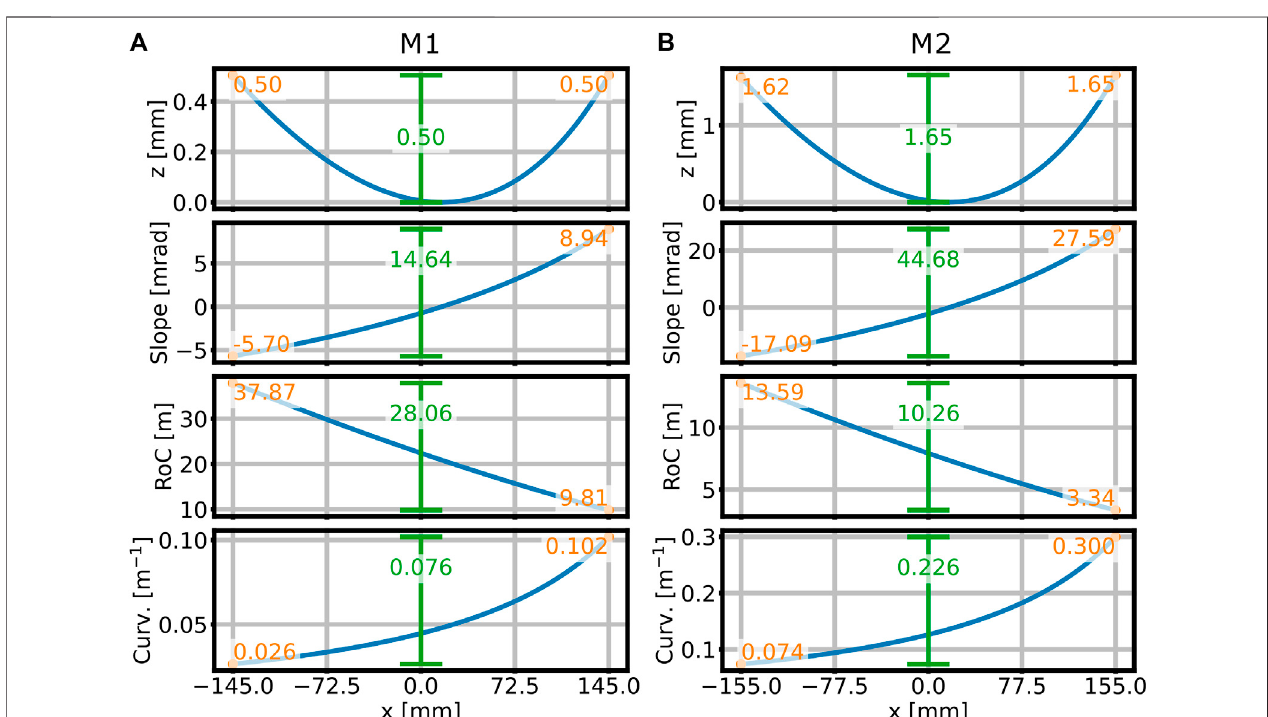
FIGURE 7 | The height, slope, RoC, and curvature pro fi les of M1 on the (A) and M2 on the (B) .